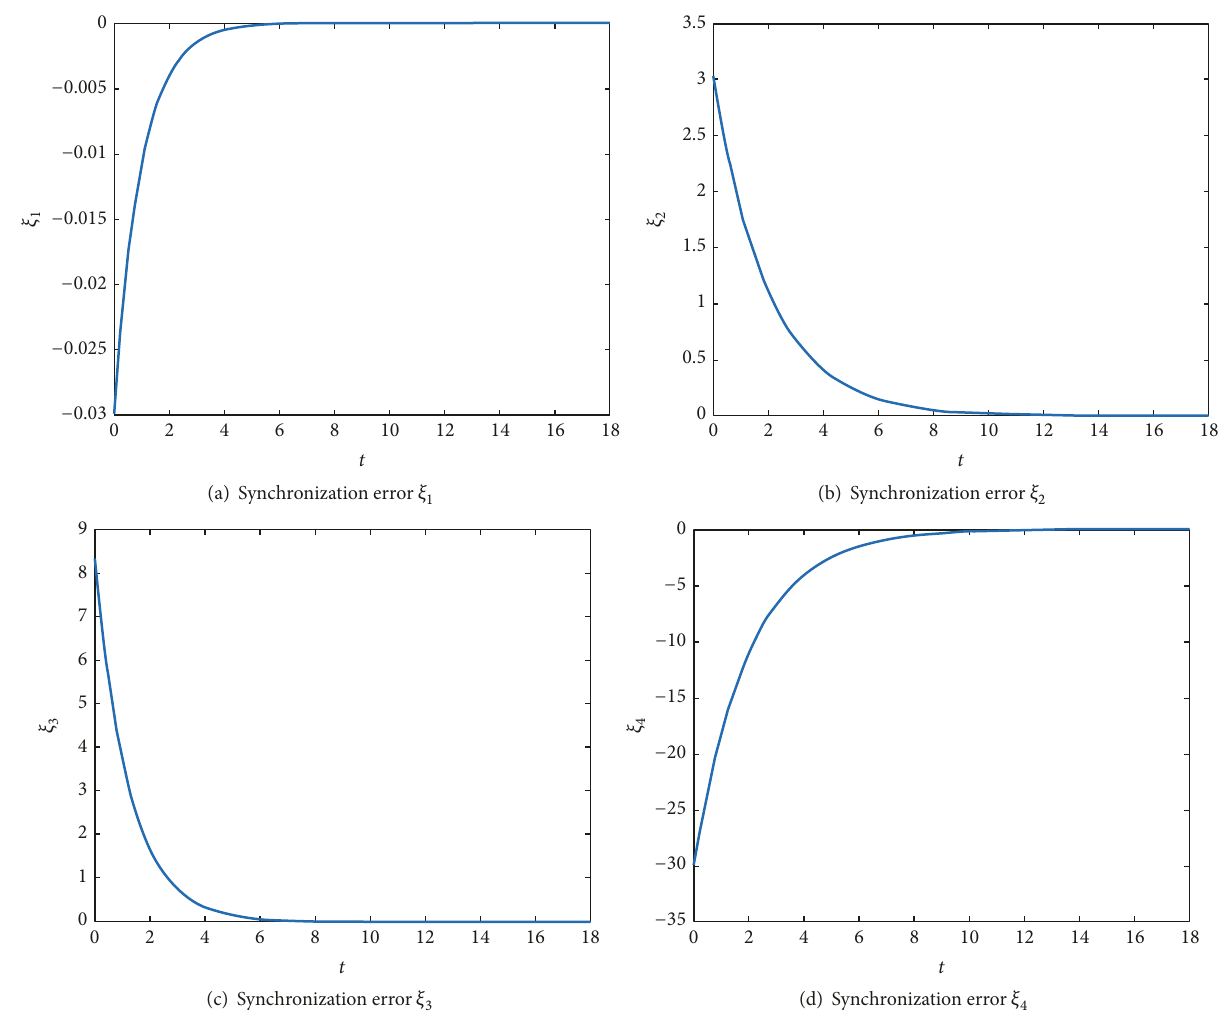
Figure 9: The history of synchronization